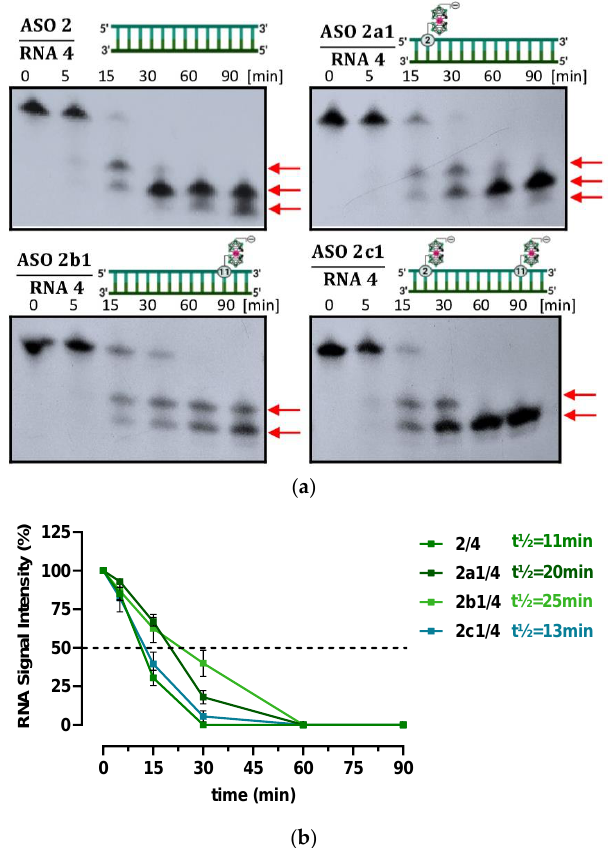
Figure 3. Autoradiograms of 20% denaturing PAGE, showing the cleavage kinetics of 5′ -[ 32 P]-la- belled RNA 4 in duplexes containing ASO 2 or B-ASO- 2 ( 2a 1 , 2b 1 , 2c 1 ), (panel a ) after treatment with RNase H (1 µL of 0.3 U/µL stock solution) at 0, 5, 15, 30, 60, and 90 min. Densitometric analyses of the kinetics of intact 5′ -[ 32 P]-RNA 4 substrate were performed using three independent PAGE anal- ysis experiments (panel b ). Red arrows indicate products of the degraded 5′ -[ 32 P]-RNA 4 . Experi- mental conditions are described in the Materials and Methods section. Figure were created in Bio- Render (https://biorender.com/, accessed on 23 June 2022) and GraphPad Prism (https://www.graphpad.com/, accessed on 15 August 2022).